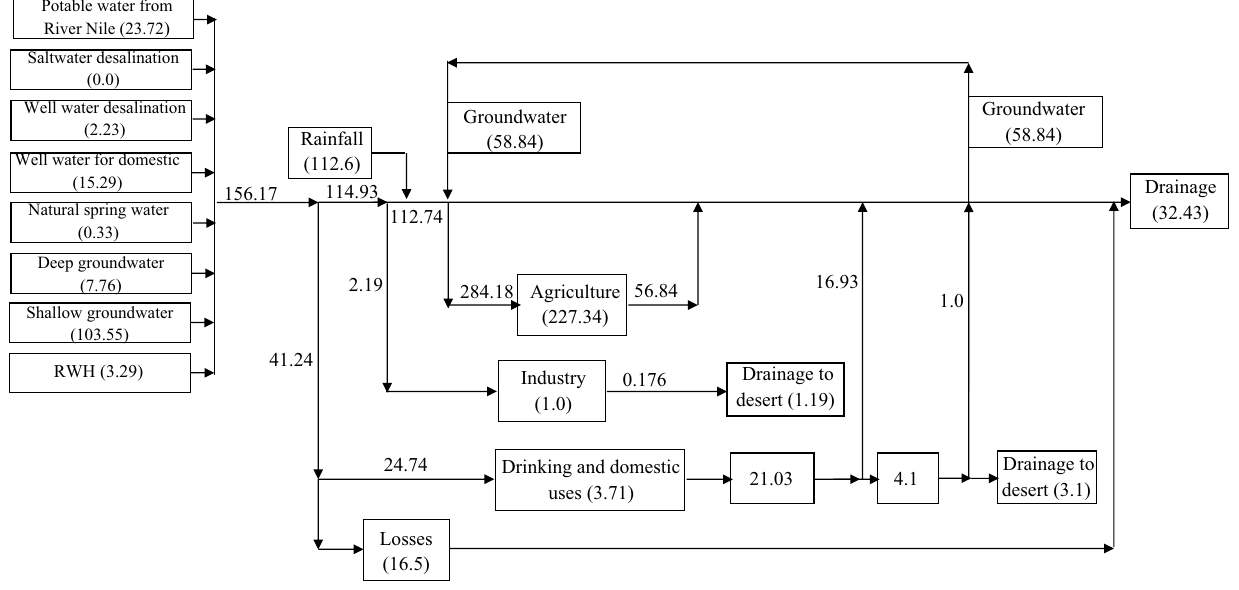
Fig. 6 Available water resources for North Sinai. Governorate and their